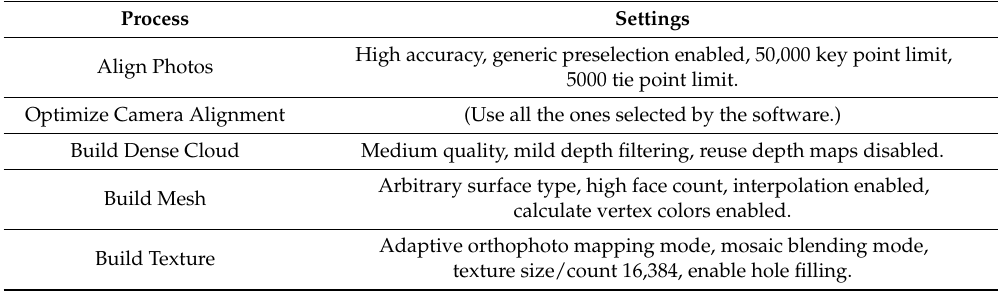
Table 1. Settings used to generate 3D models in Agisoft PhotoScan Professional (v. 1.4).